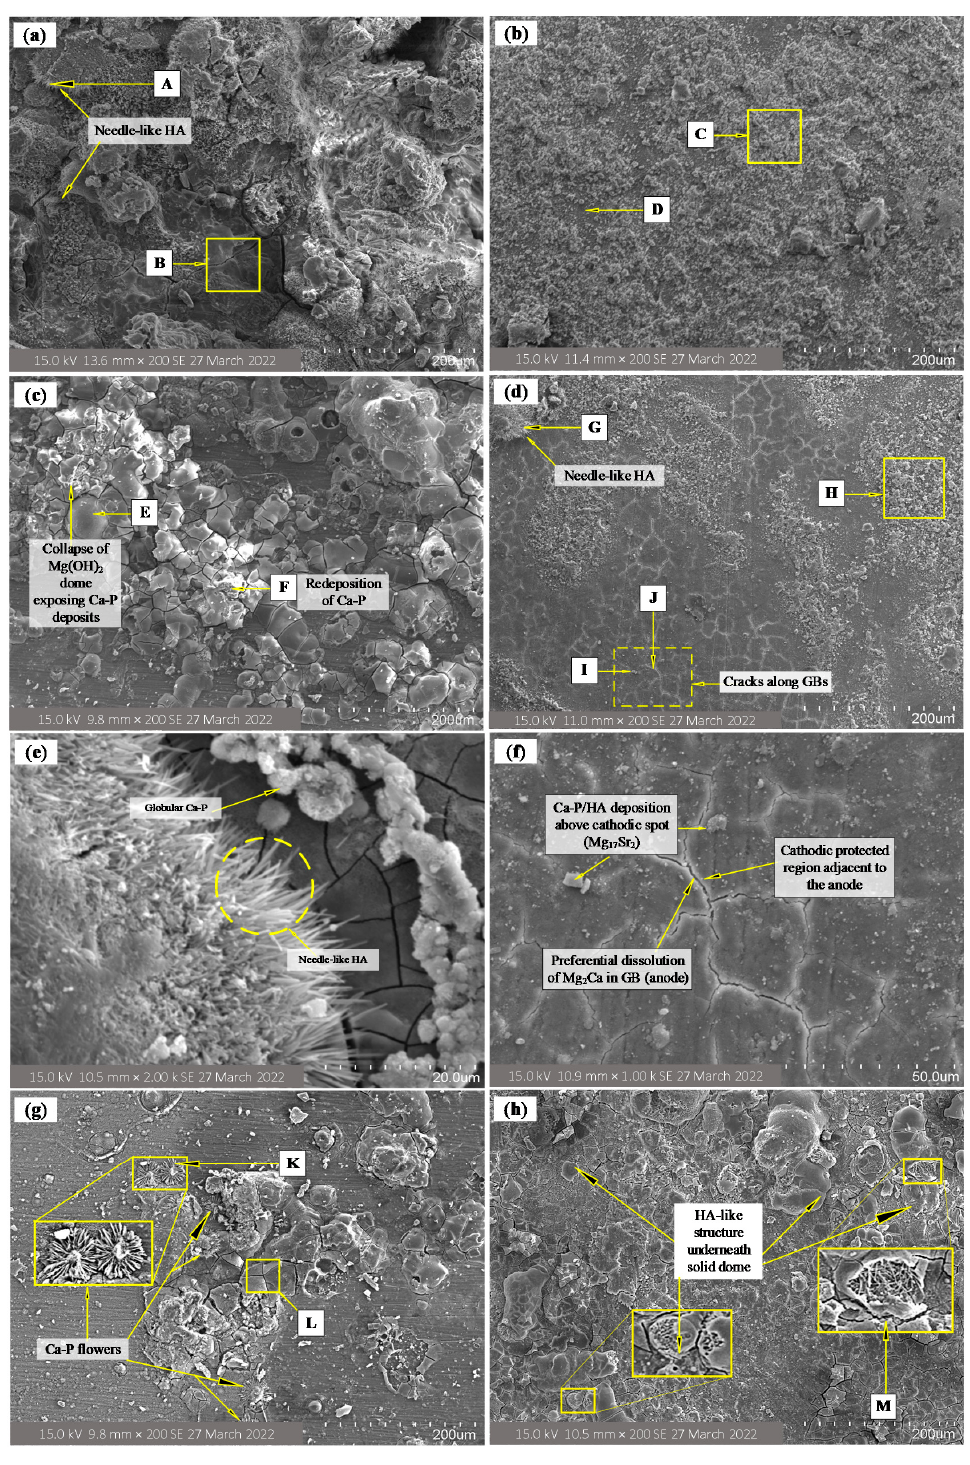
Figure 4. SEM image of deteriorated surface of CP Mg and Mg-1.0Ca-0.5Sr alloy in r-SBF under different pH regulation treatment. CP Mg in ( a ) uninterrupted r-SBF solution, MgSBFx; ( b ) interrupted r-SBF solution, MgSBFR; and ( c ) Tris-HCL buffered r-SBF solution, MgSBFT. Mg-1.0Ca-0.5Sr alloy in ( d ) uninterrupted r-SBF solution, M2SBFx; ( g ) interrupted r-SBF solution, M2SBFR; and ( h ) Mg-1.0Ca-0.5Sr alloy in Tris-HCL buffered r-SBF solution, M2SBFT. The images ( e , f ) show a magnified perspective of the dotted square and needle-like HA structure in ( d ). The annotated yellow points and areas (A–M) in SEM images correlate to the locations of the EDS analysis (Table 5).